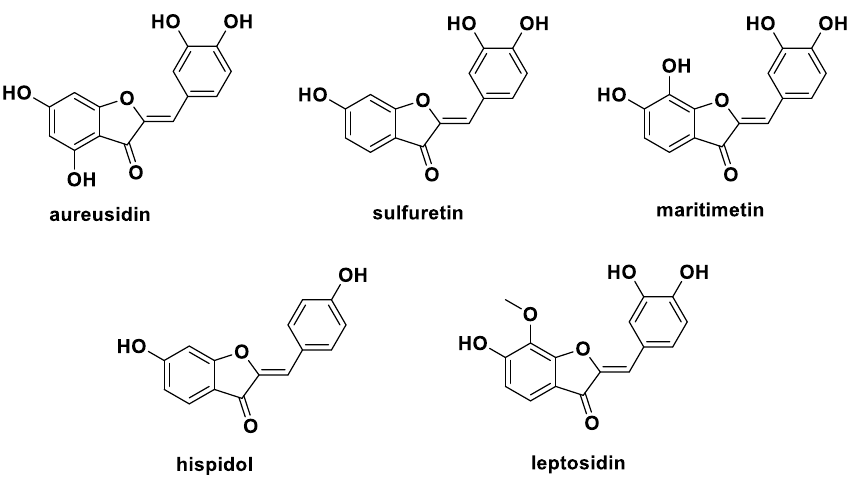
Figure 1. Structures of aurones isolated from plants.